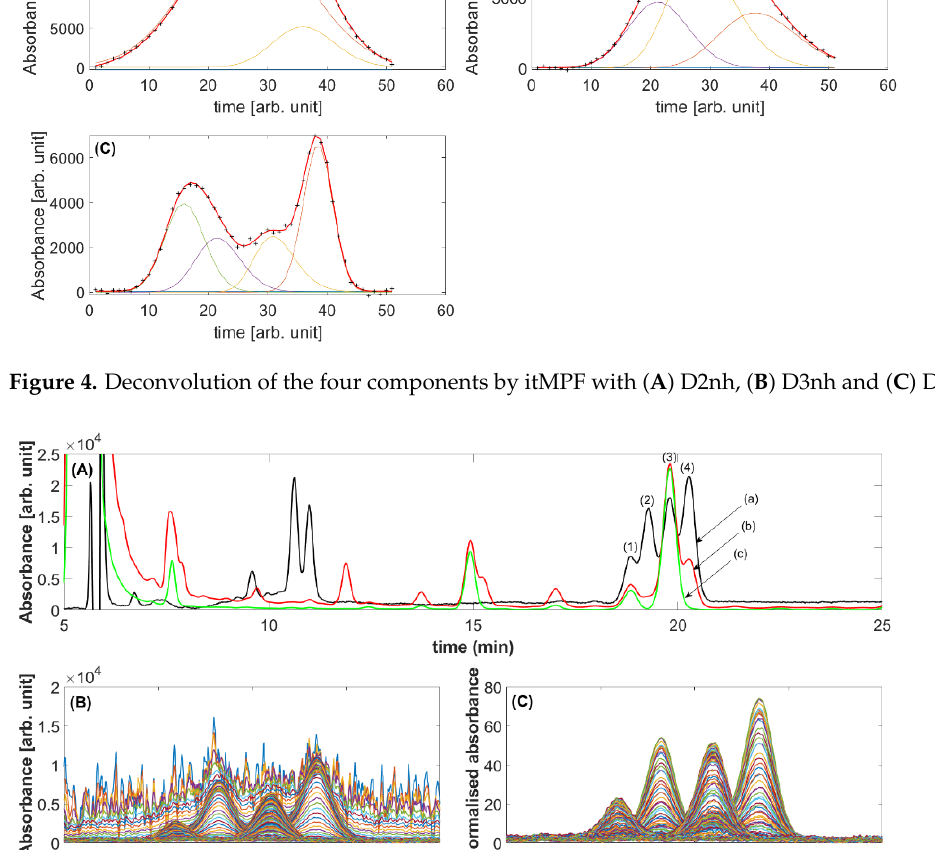
Figure 5. ( A ) Typical chromatograms; (a) standard mixture, (b) coffee analyzed using the full wavelength range, (c) coffee analyzed at 290 ± 4 nm; (1) kahweol oleate, (2) cafestol oleate, (3) kahweol palmitate and (4) cafestol palmitate. ( B ) Superposition of all channels corresponding to the target compounds between 18 and 22 min. ( C ) noise normalized intensities.